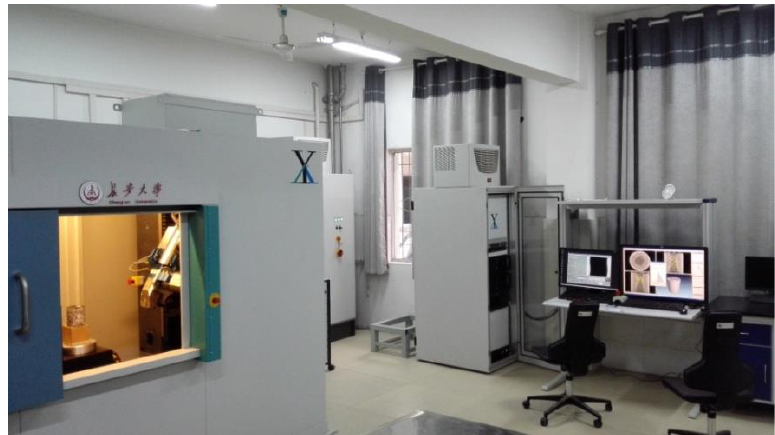
Figure 3. Industrial computed tomography imaging system.